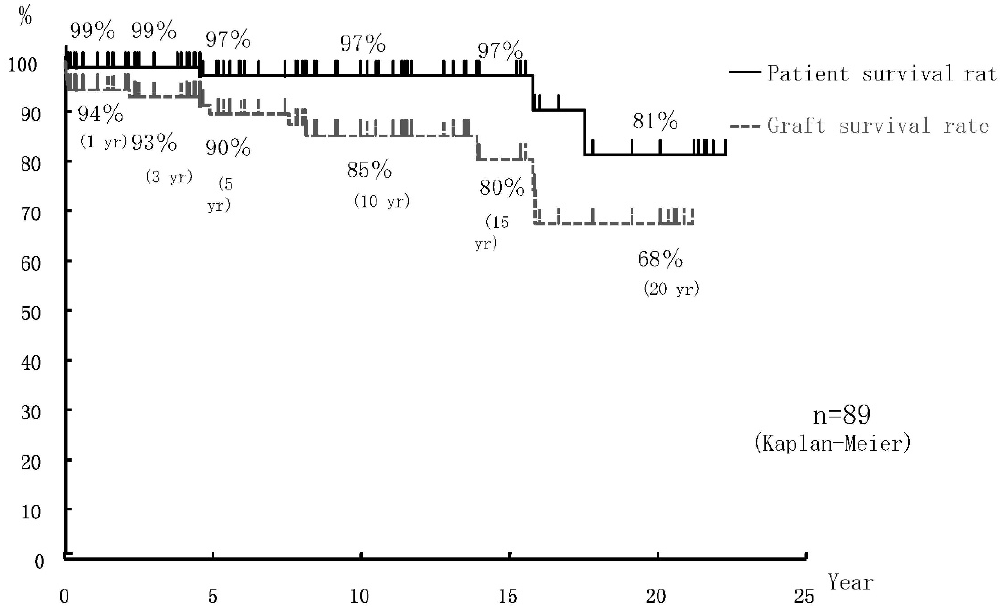
Figure 2 - Overall Patient and Graft Survival Rates (Age , 16